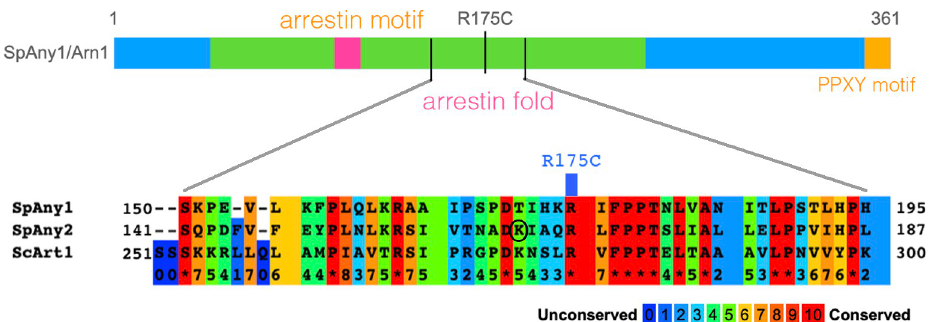
Fig 2. Location of the R175C mutation in Any1. The lower panel shows an alignment of S . pombe Any1, Any2 and S . cerevisiae Art1, generated by Praline [29].